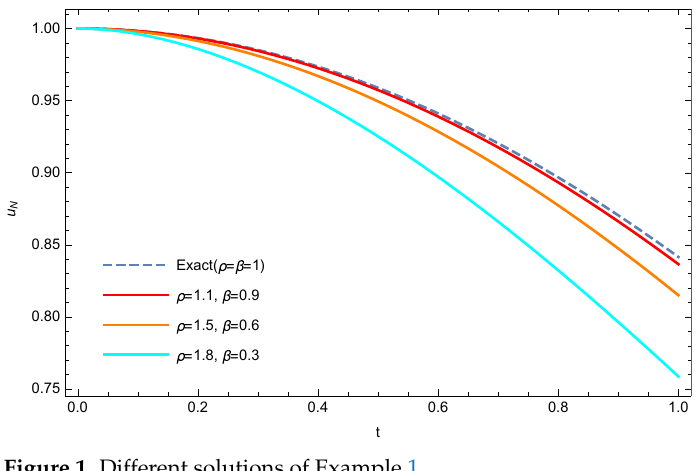
Figure 1. Different solutions of Example